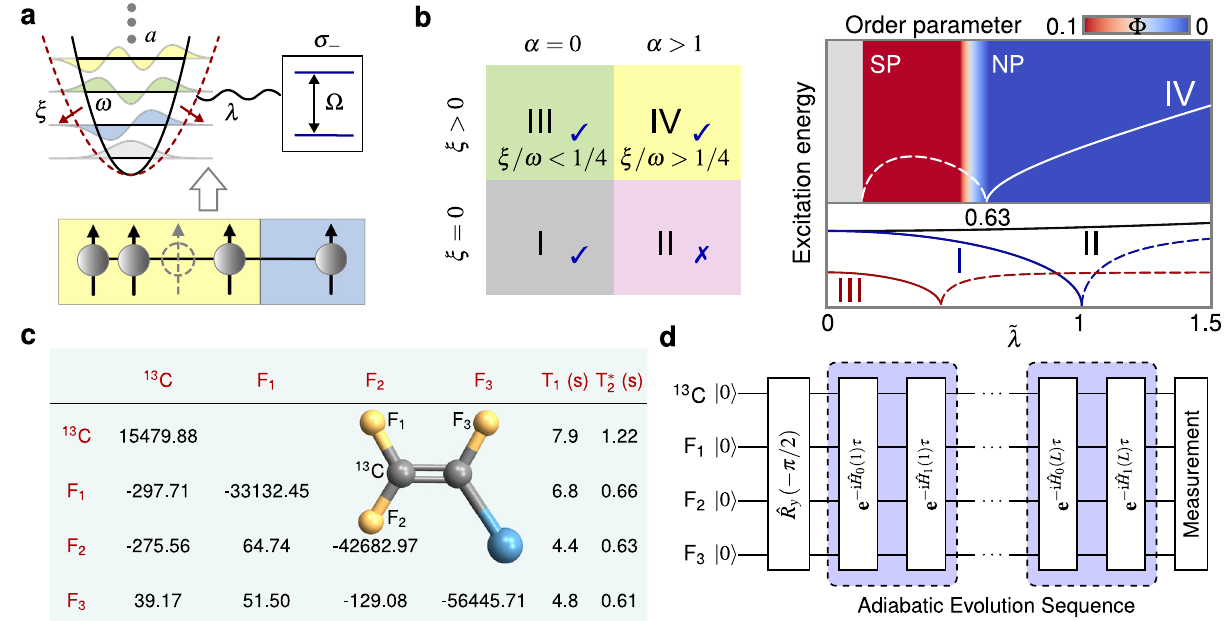
Fig. 1 Theoretical model, phase diagram, physical system, and quantum circuit for implementing SPT. a N + 1 spins are used to simulate the quantum Rabi model consisting of a two-level system coupled to a Boson fi eld with 2 N harmonic levels with coupling strength λ . The red arrows and dashed line- potential indicate the antisqueezing effect. b Phase transition property in the limit Ω / ω → ∞ , described by the lowest excitation energy and the order parameter Φ in the parameter regimes from I to IV de fi ned by the values of ξ and α . The occurrence and disappearance of SPT are indicated by tick and cross, respectively. The solid and dashed lines correspond to the NP and SP, respectively. c , Molecular structure of 13 C-iodotriuroethylene and the relevant parameters. The diagonal and off-diagonal elements represent chemical shifts and J-couplings (all in Hz), respectively. d , Quantum circuit for for implementing SPT including the adiabatic ground state preparation with ^ H 0 ð l Þ ¼ ½ 1 (cid:2) s ð l Þ(cid:5) ^ H 0 , ^ H 1 ð l Þ ¼ s ð l Þ ^ H s , where l = 0, 1, 2 … L , and s ( l ) slowly changes from 0 to